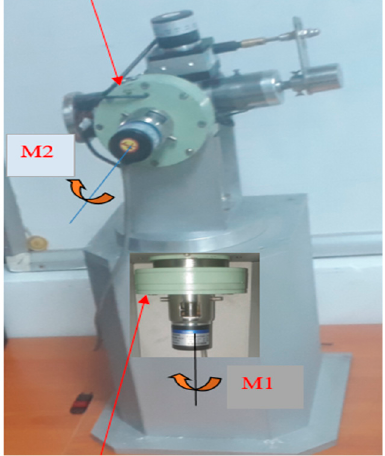
Figure 11. Assembly design of the linear MR brake.